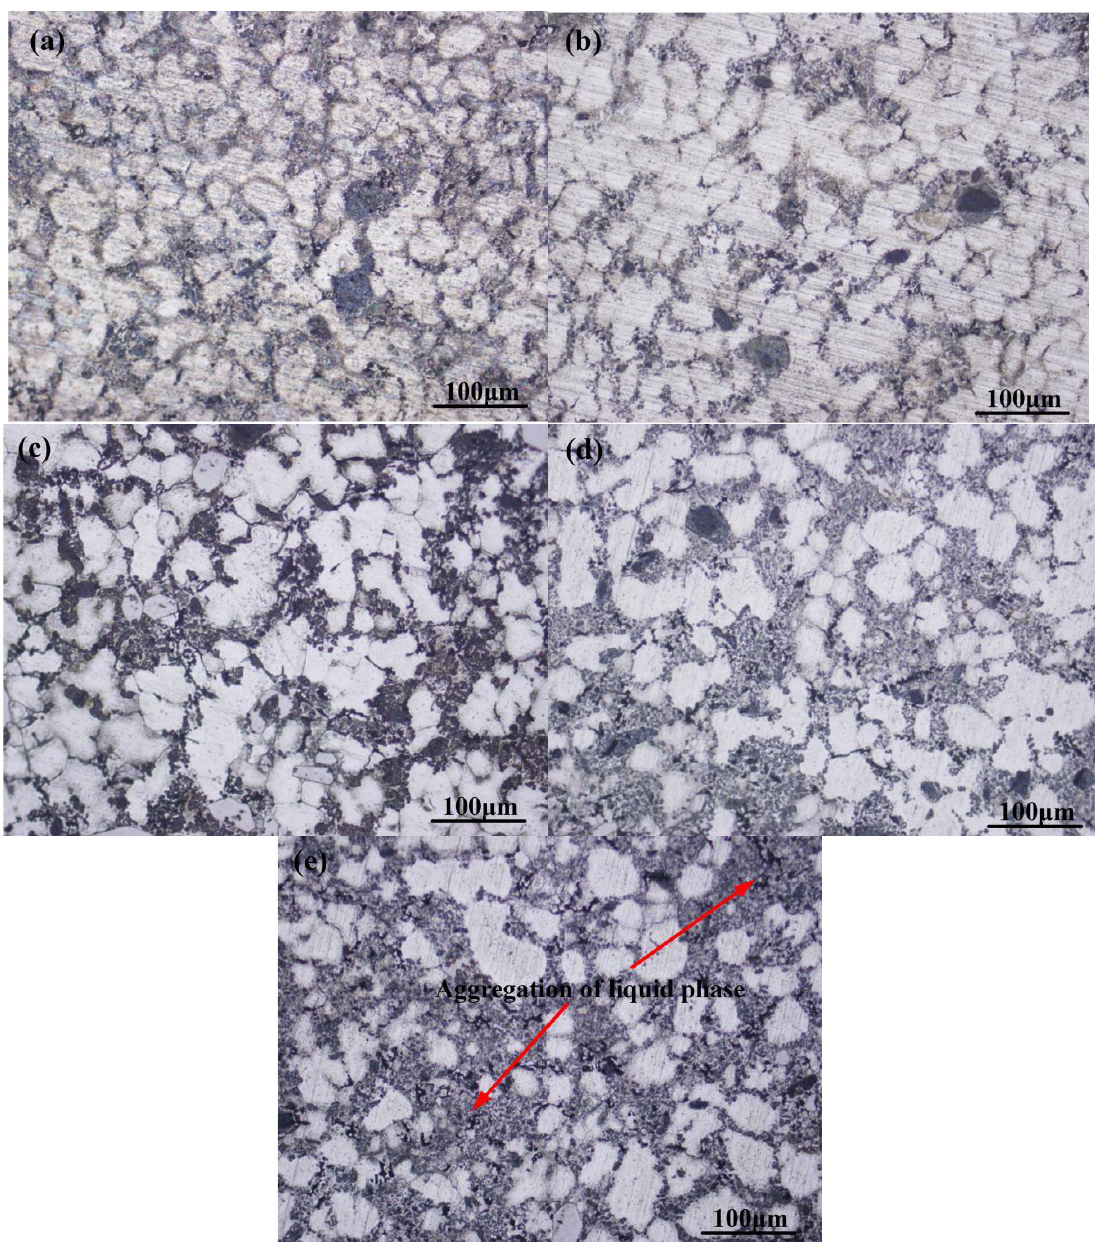
Figure 8. OM microstructure in location B of rheoformed 2024 aluminum matrix composite component reinforced by 5 vol % Al 2 O 3 nanoparticles for 25 min stirring time at various stirring temperatures ( a ) 610 °C; ( b ) 615 °C; ( c ) 620 °C; ( d ) 625 °C; ( e ) 630 °C.